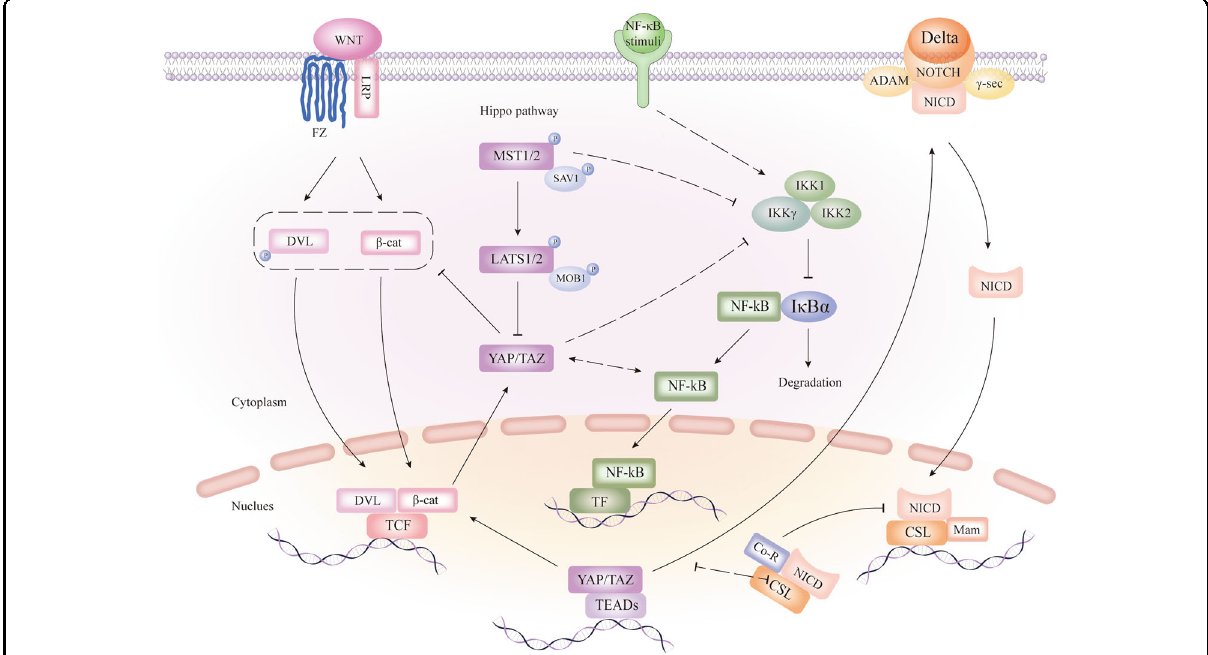
Fig. 2 The mutual interaction of WNT, Notch, and Hippo pathway in the intestine. Cytoplasmic YAP/TAZ inhibits WNT target gene expression via DVL phosphorylation and β -catenin activation, whereas nuclear YAP promotes WNT signalling by cooperating with β -catenin. YAP/TAZ may also be activated by activated β -catenin. MST1 and YAP can indirectly inhibit the regulatory subunit IKK γ , leading to the inhibition of NF- κ B. Besides, YAP and NF- κ B can both inhibit and activate each other indirectly in different situations. In addition, YAP/TAZ may activate Notch signalling through transcriptional regulation. Arrows and blunt ends indicate activation and repression, respectively. The dotted line represents the indirect regulation. Fz, frizzled; LRP, low-density lipoprotein receptor-related protein; DVL, dishevelled; β -cat, β -catenin; TCF, T-cell factor; MST1/2, mammalian sterile 20- like 1/2; SAV1, salvador; LATS1/2, large tumour suppressor homologue 1/2; MOB1A/B, MOB kinase activator 1A/B; YAP, yes-associated protein; TAZ, transcriptional co-activator with PDZ-binding motif; TEAD, TEA domain family member; NF- κ B, nuclear factor NF- κ B; IKK, I κ B kinase; I κ B α , NF- κ B inhibitor; ADAM, ADAM-family metalloproteases; γ -sec, γ -secretase; NICD, Notch intracellular domain; CSL, CBF1, Su(H) and LAG-1; Co-R, co-repressor; Mam,